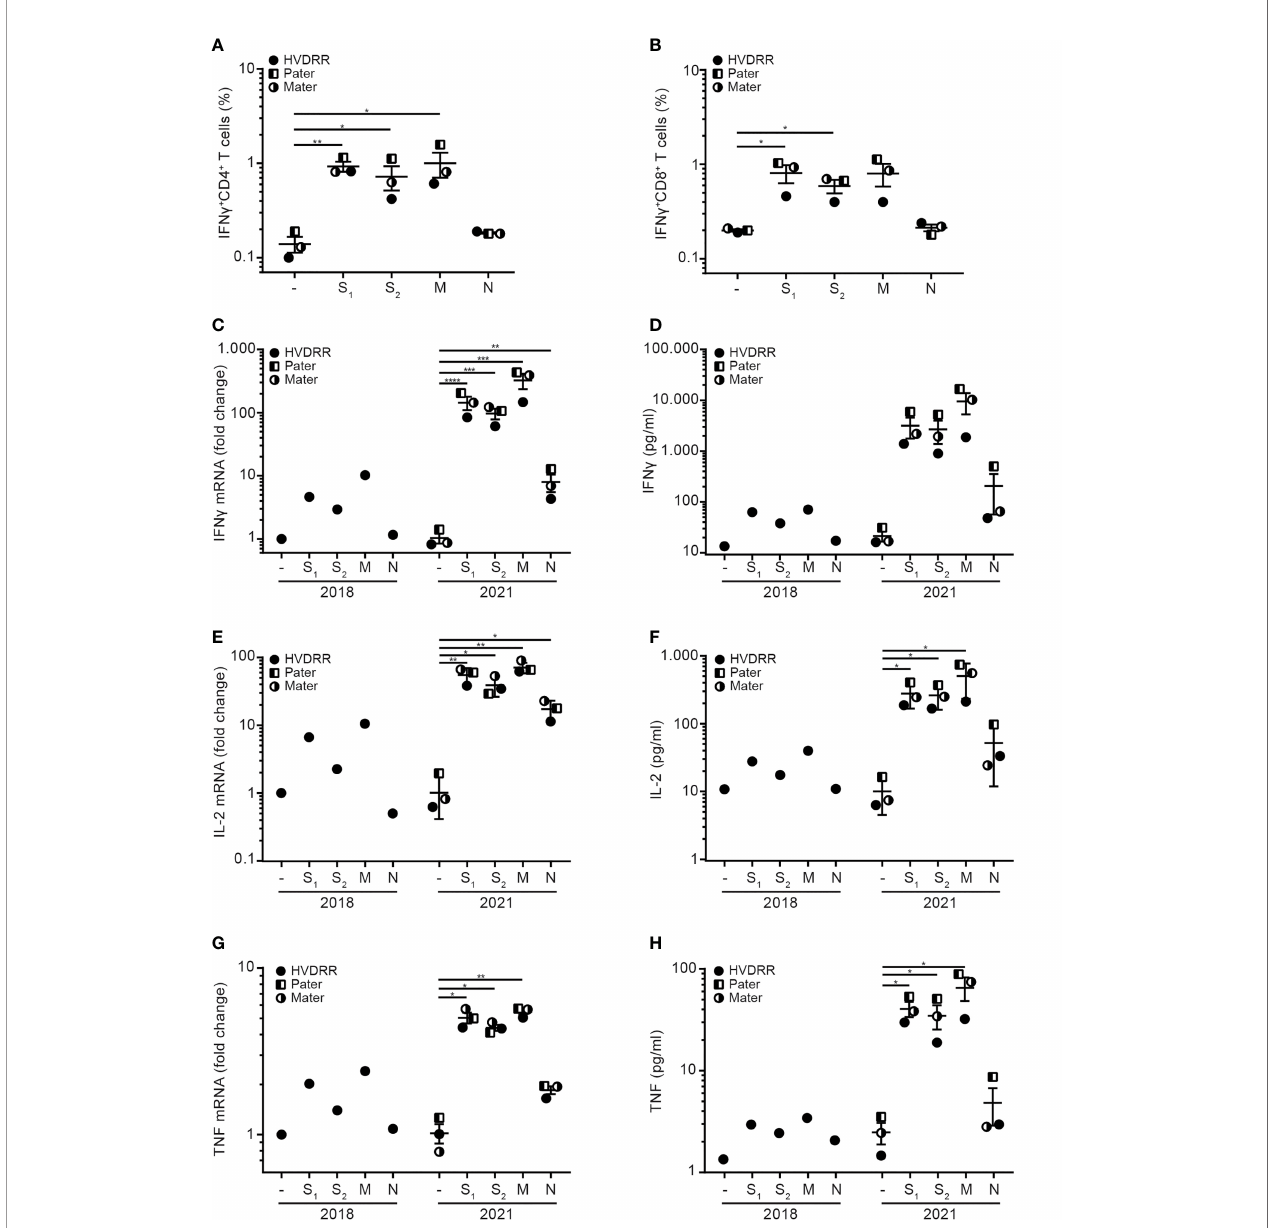
FIGURE 2 | Normal cytokine pro fi le of SARS-CoV-2-speci fi c T cells from the HVDRR patient and her parents. Frequency of IFN g + (A) CD4 + and (B) CD8 + T cells in PBMC treated with DMSO (-) or peptide pools encompassing the fi rst half of the spike protein (S 1 ), the second half of the spike protein (S 2 ), the membrane protein (M) and the nucleoprotein (N). Samples were from the HVDRR patient ( fi lled circles), pater (half- fi lled squares) and mater (half- fi lled circles). Data are shown as mean ± SEM. (C – H) Cytokine mRNA and cytokine concentration in the supernatants of PBMC obtained from the HVDRR patient in 2018 and from the HVDRR patient and her parents in 2021 and stimulated as described above. The mRNA expression levels of (C) IFN g , (E) IL-2 and (G) TNF are shown as geometric mean ± SD. Concentrations of (D) IFN g , (F) IL-2 and (H) TNF in the supernatants are shown as mean ± SEM; *p < 0.05; **p < 0.01; ***p < 0.005; ****p <